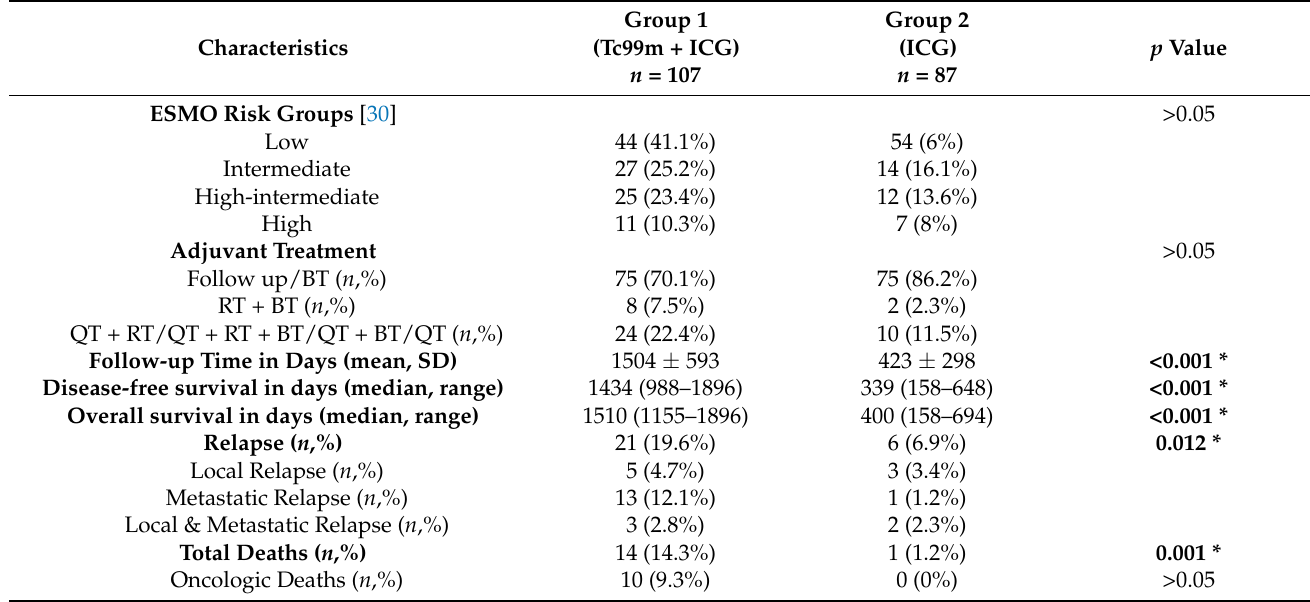
Table 3. Follow-up and adjuvant treatment ( n = total number of patients; SD = standard deviation; ICG = indocyanine green; Tc99m = Technetium99; BT = brachytherapy; RT = external radiotherapy; QT = chemotherapy; * significant